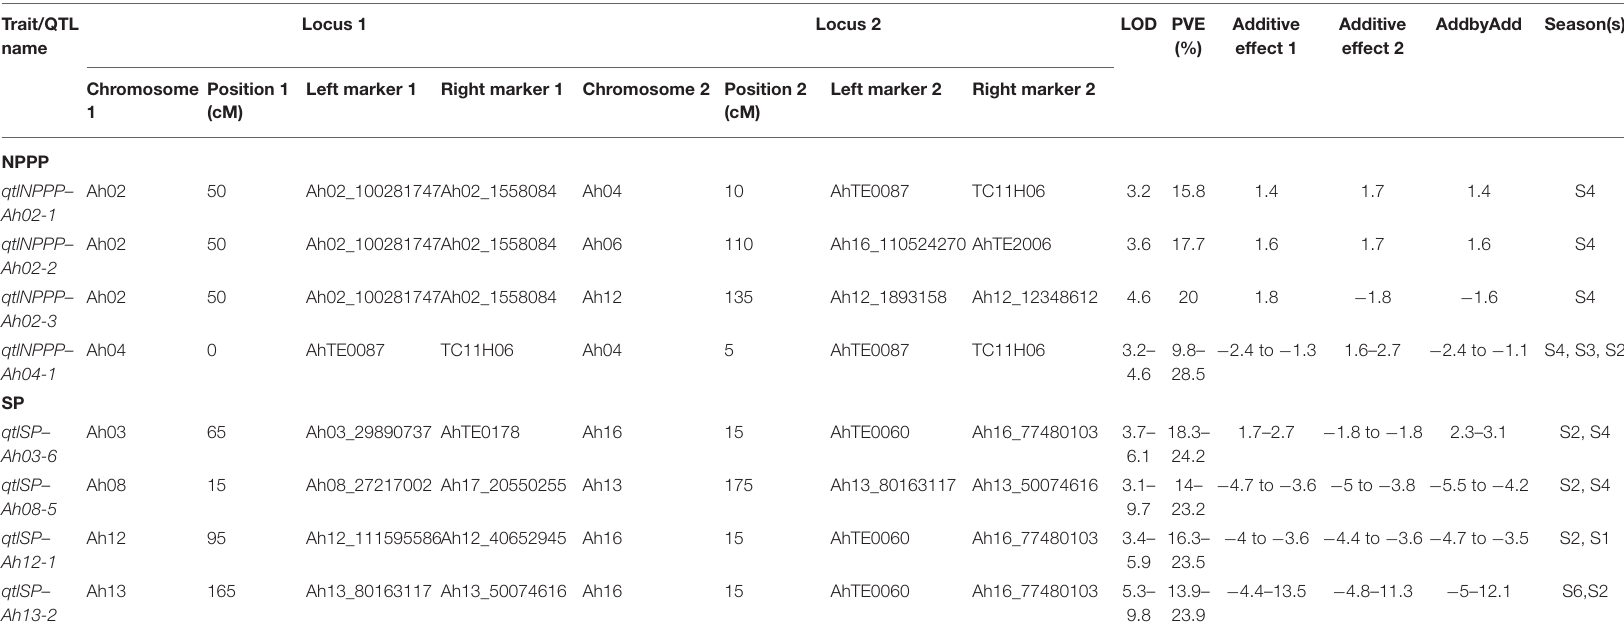
TABLE 3 | Major main effect QTLs showing major epistatic interaction for productivity traits across seasons in the RIL population of TMV 2 and TMV 2-NLM of